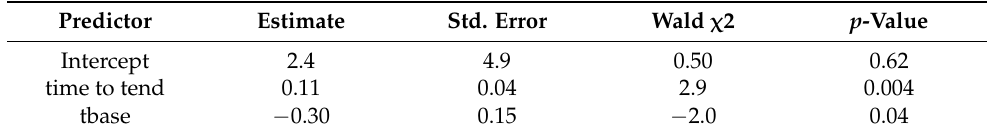
Table 1. The prediction model generated from 22 patients with pRP. Reproduced from reference [8]. The time to t end = time to end temperature. The t base = baseline finger